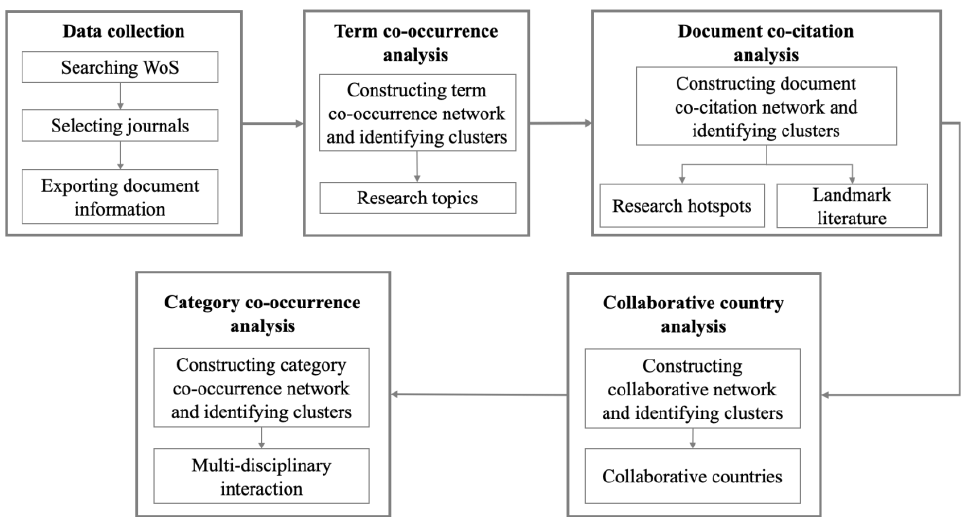
Figure 1. The overall framework of the scientometric survey in the domain of 3D point cloud data for cultural heritage.